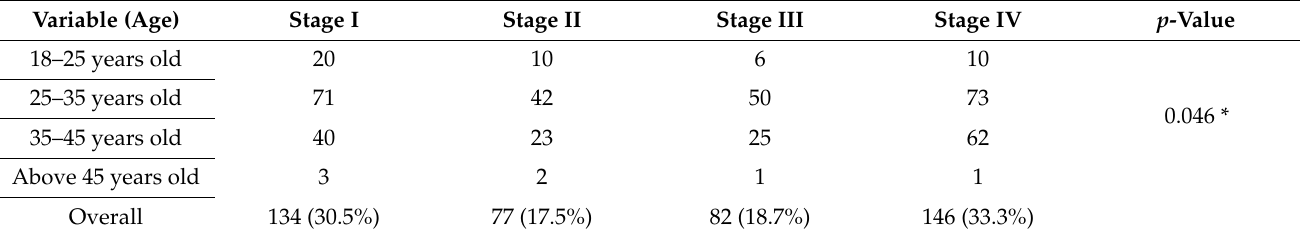
Table 2. The division of the study group according to endometriosis staging with regard to age